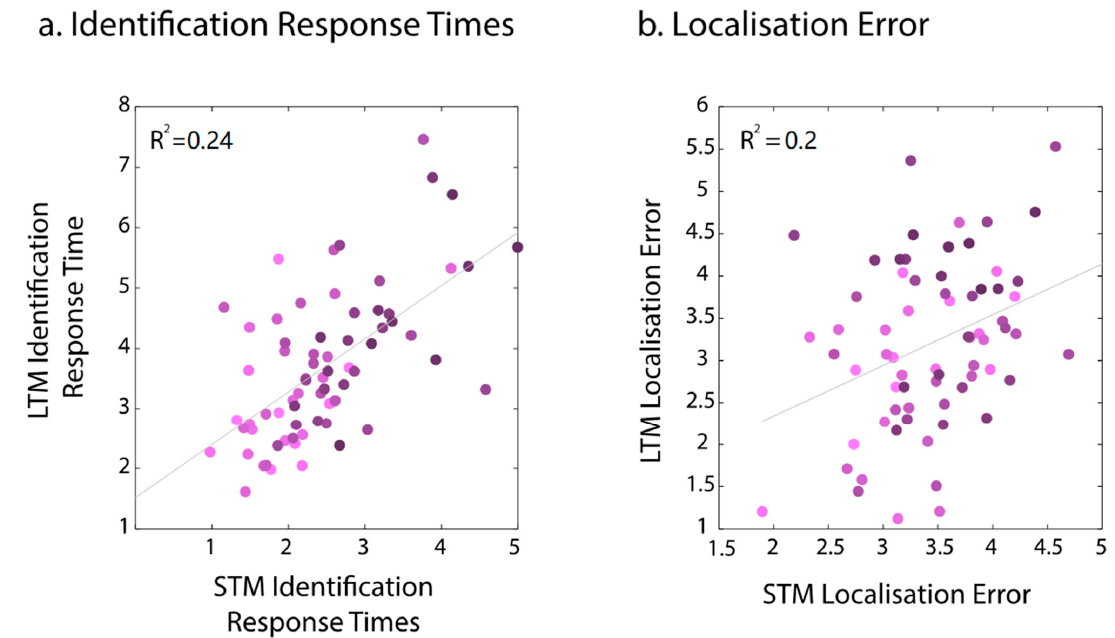
Figure 6. The relationship between STM and LTM for Identification times ( a ) and localisation errors ( b ) in Experiment 2. Dots represent individual participants’ means. Saturation changes reflect the age of participants.